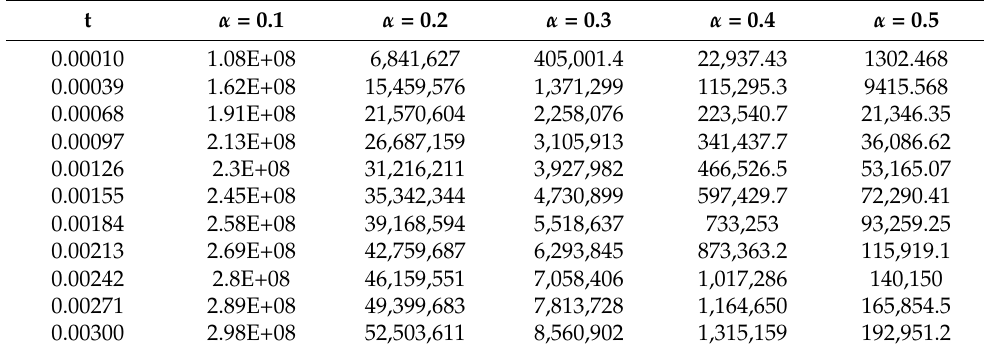
Table 1. Numerical results of neutron flux at different values of α , ψ 0 ( x ) =